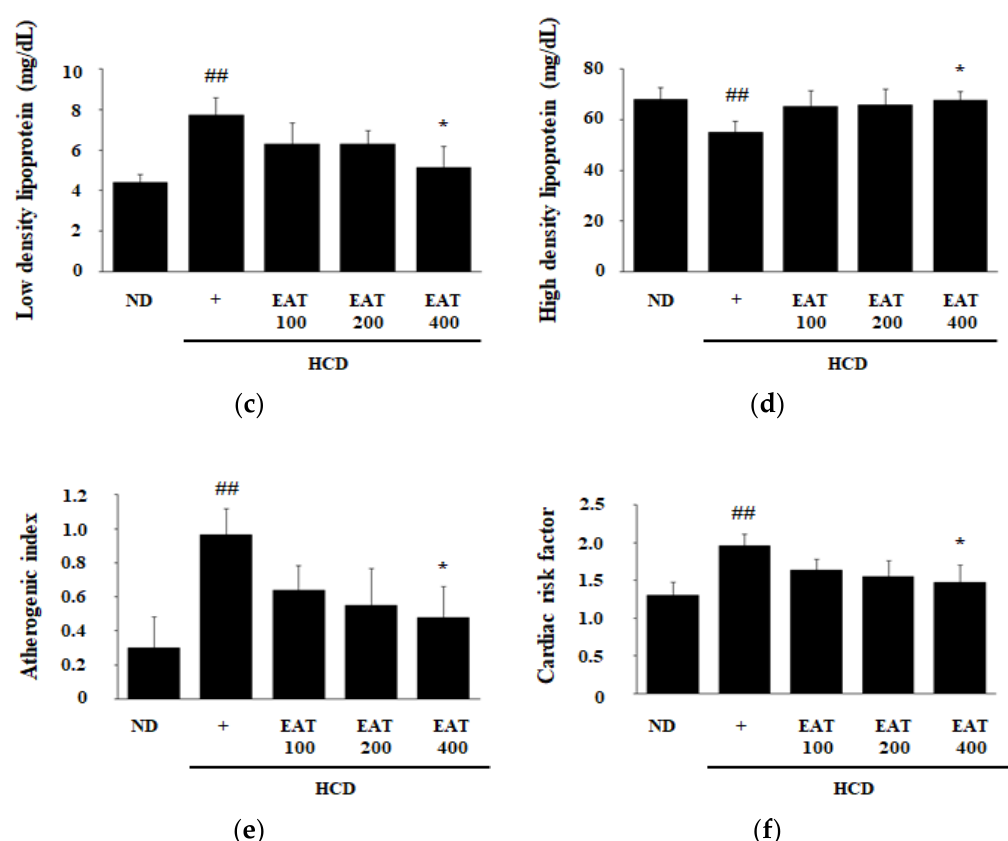
Figure 3. Effect of EAT on the plasma lipid profile and cardiovascular disease risk in an HCD-induced C57BL/6 mouse model. ( a – d ) Blood was collected for centrifugation at 3000 rpm for 15 min at 4 °C to separate plasma for analysis of the change in plasma lipid profile at the end of the experiment. Plasma lipid profile including ( a ) total cholesterol (TC), ( b ) triglyceride (TG), ( c ) low-density lipoprotein (LDL), and ( d ) high-density lipoprotein (HDL) was analyzed by biochemical analyzer. ( e , f ) The risk index of cardiovascular disease determined as ( e ) atherogenic index (AI) and ( f ) cardiac risk factor (CRF) was based on TC and HDL. AI = (TC − HDL)/HDL, CRF = TC/HDL. Values are expressed as mean ± SD; ## p < 0.01 compared with the ND group; * p < 0.05 compared with the HCD group.